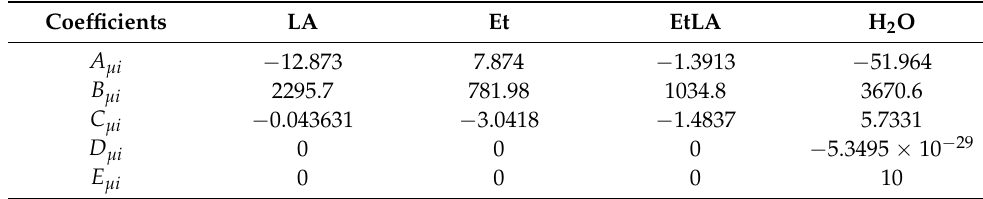
Table 4. Numerical values of the coefficients used to calculate the viscosity of each component, dependent on temperature